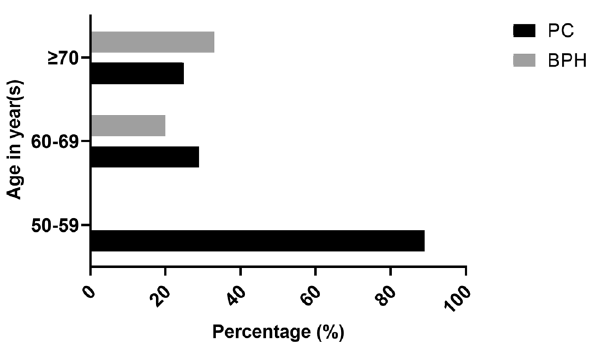
Figure 2. TT genotype distribution according to age at diagnosis within PC and BPH groups.